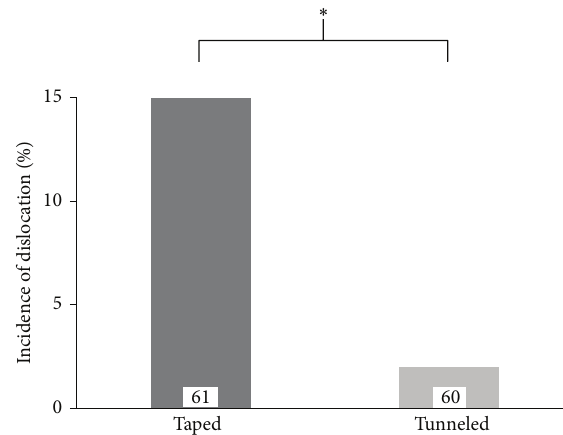
Figure 3: Incidence of catheter dislocation > 20 mm. Data was available for 𝑛 = 121 patients (61 taped/60 tunneled). Fisher’s exact testwasusedtocalculatestatisticalsignificance( ∗ 𝑃 < 0.01 ).Relative risk was 0.3389 [95% CI